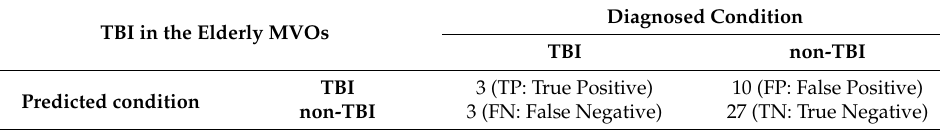
Table 5. Verification results of the diagnosed TBI and predicted